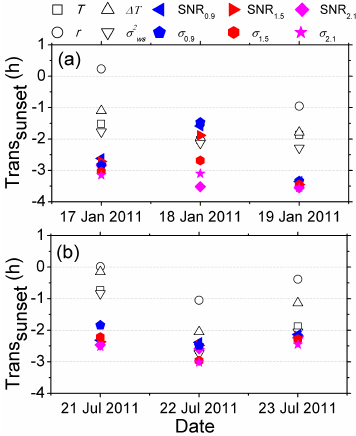
Figure 7. The start time of the AT with reference to the time of sunset as obtained by different state variables at the surface and aloft during (a) 17–19 January 2011 and (b) 21–23 July 2011.